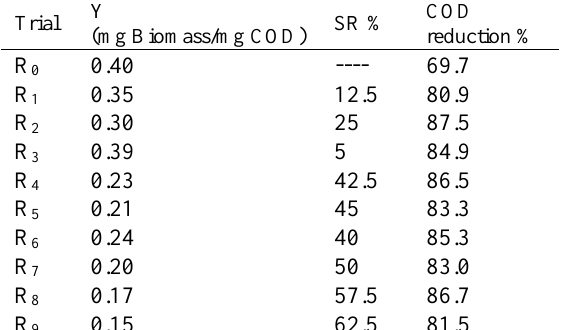
Table 7. Values of Y reduction, SR (n%), and